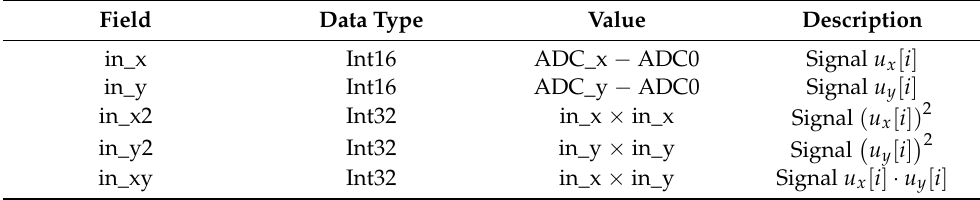
Table 1. Calculations of the auxiliary